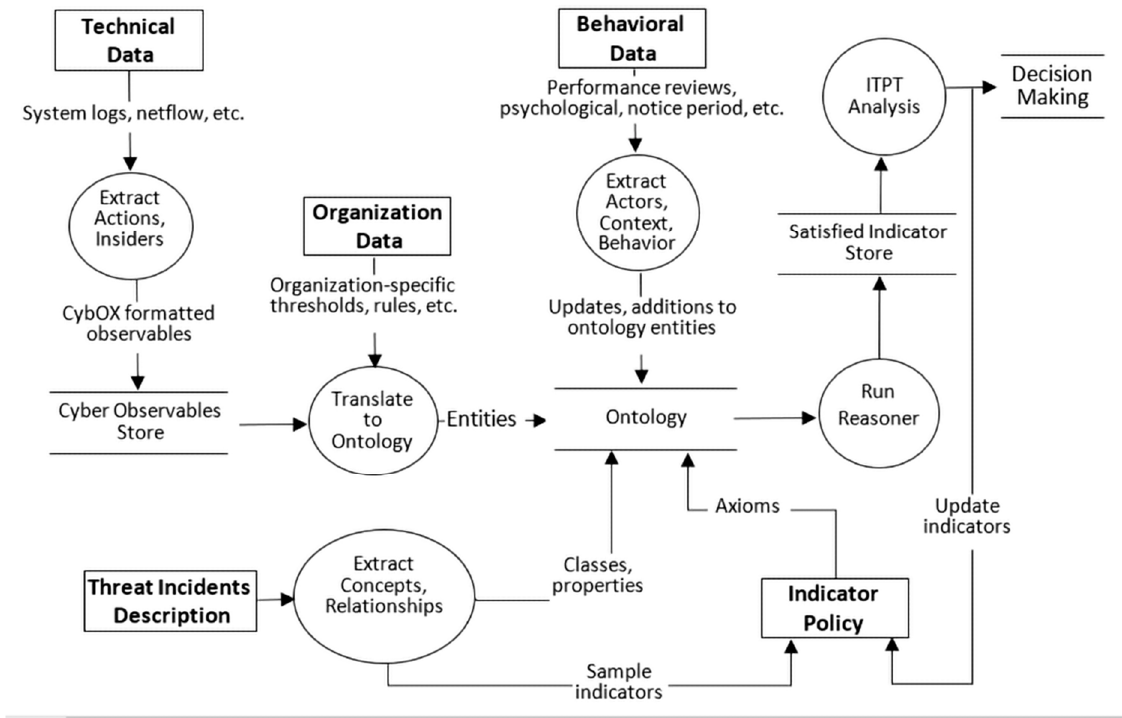
Figure 5. Data flow diagram of the framework.